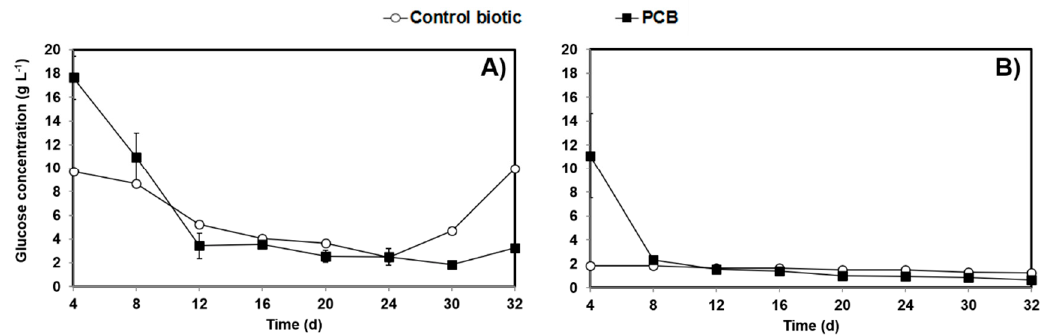
Figure 1. Glucose concentration in the culture medium of treatments with and without printed circuit boards (PCBs): ( A ) A. niger MXPE6; ( B ) fungal consortium ( A. niger MXPE6 + A. niger MX7). Data are provided as means ± standard error; n = 3.